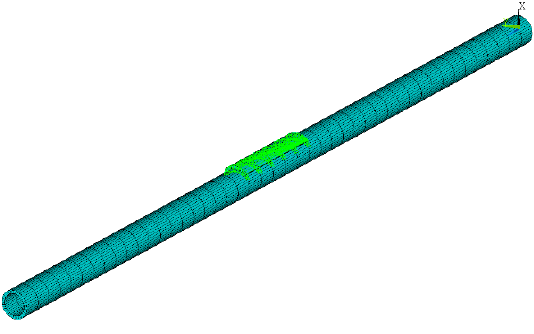
Figure 6. Fixed boundary.